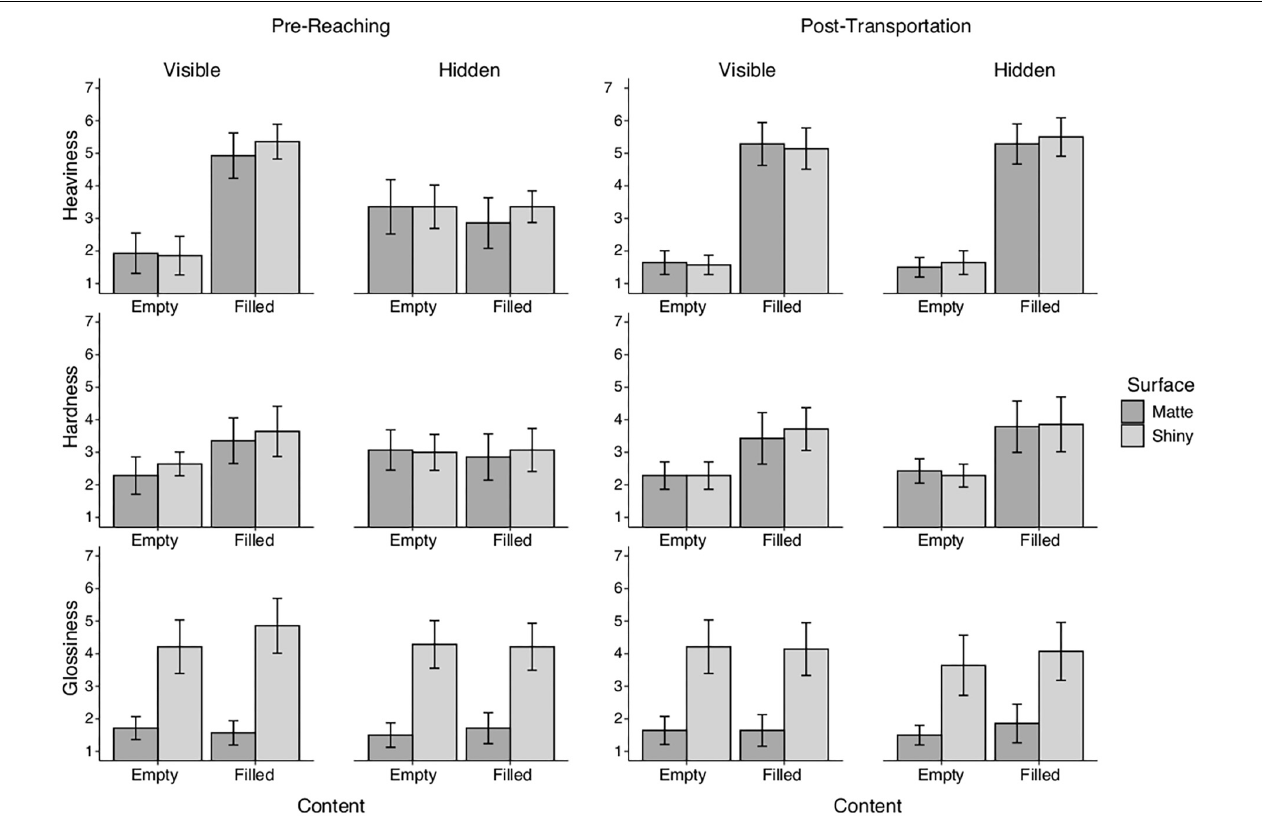
FIGURE 3 | Mean rated heaviness, hardness, and glossiness for the eight stimuli. (Left) Ratings collected before reaching for the stimuli. (Right) Ratings collected after transporting the stimuli. Error bars are 95% confidence intervals. The two graphs suggest that the pre-reaching ratings are based on expectations whereas the post-transportation ratings are based on sensorimotor information. The figure also suggests strong categorical impressions of the properties, heaviness, and glossiness (bimodal values) whereas the impression of hardness is less